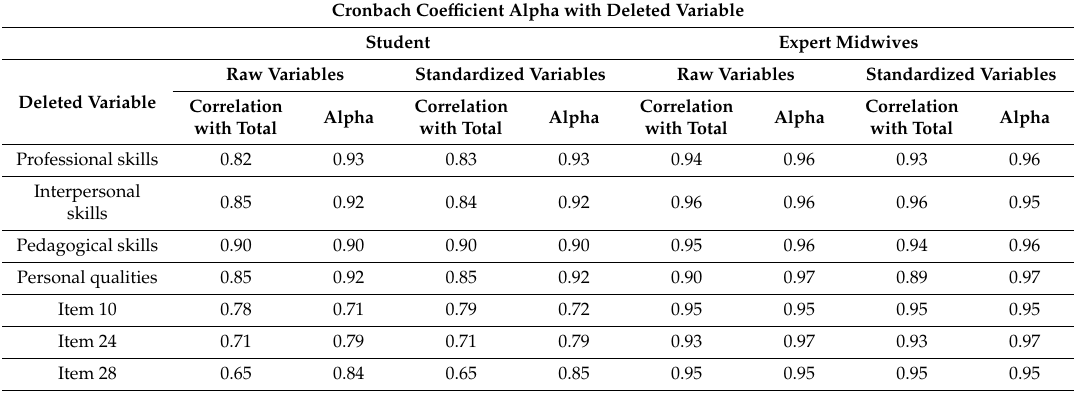
Table 4. Cronbach Coefficient Alpha calculated on forms filled in by students ( n . 47) and expert midwives [ n . 50].